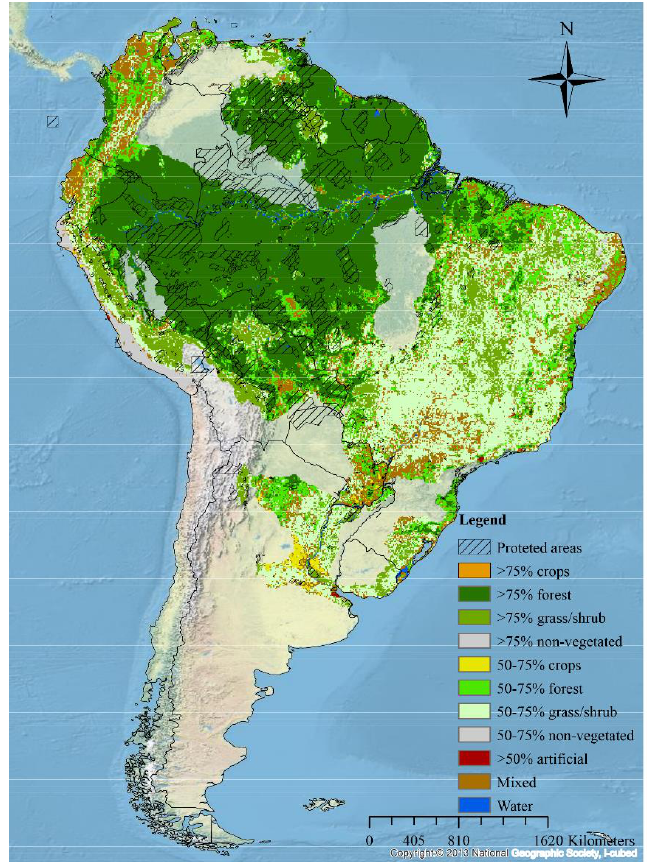
Figure 4. Land use characteristics in South America within the water lily ( Nymphaea )-accessible area (M), indicating the land use category in protected and unprotected areas.